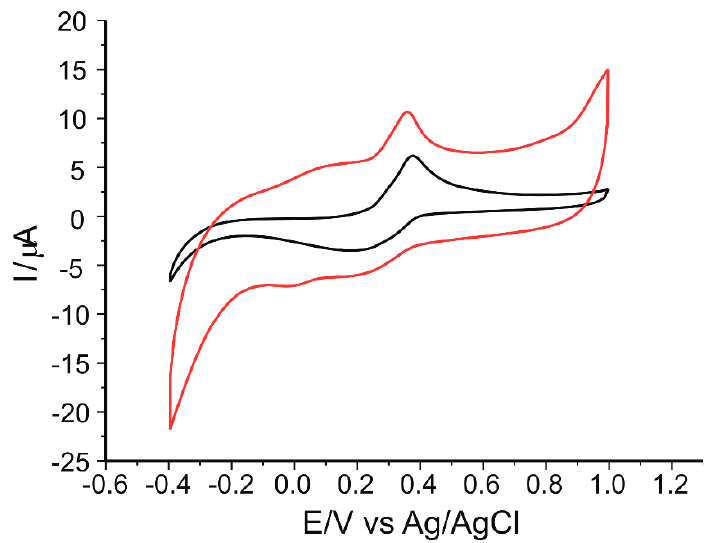
Figure 8. CVs of SPCE/GPHOX (black line) and SPCE/GPHOX-Pentapeptide (red line) immersed in 10 − 4 M verbascoside–0.1 M PBS solution (pH 6.5). Scan rate: 0.05 V·s − 1